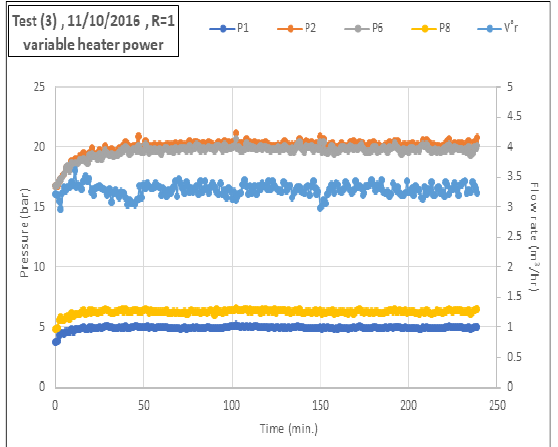
Fig. 12c. Power consumption, cooling capacity, electrical heater power and coefficient of performance with time for test